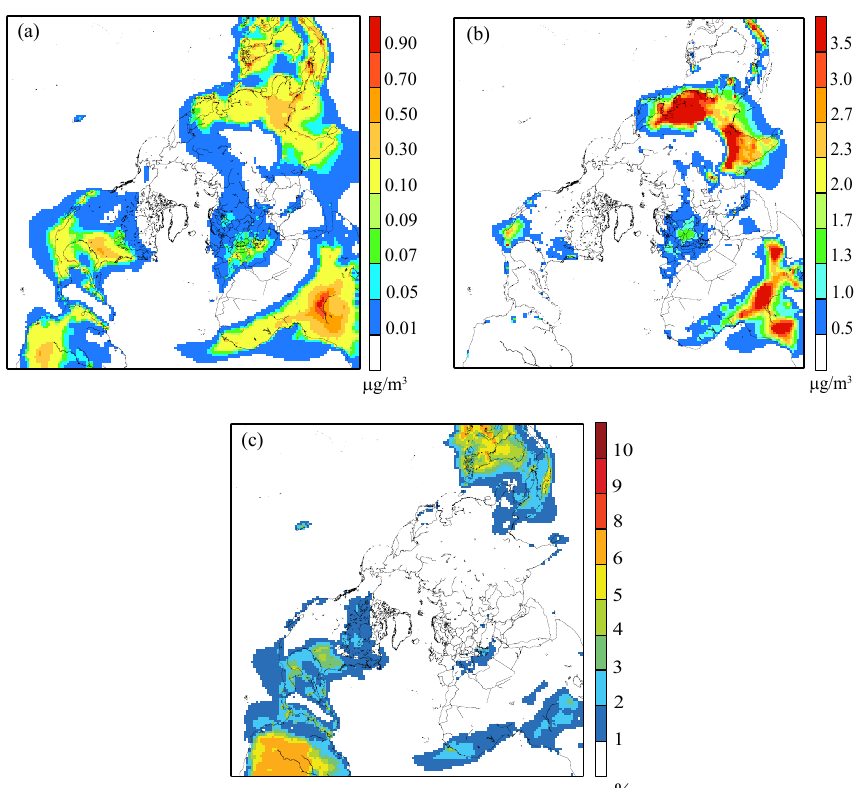
Fig. 5. Geographical distributions of annual average (a) SOA and (b) POA concentrations (µgm − 3 ) simulated by DEHM for the year 2006. (c) shows the ratios of SOAs to total OAs (POAs +